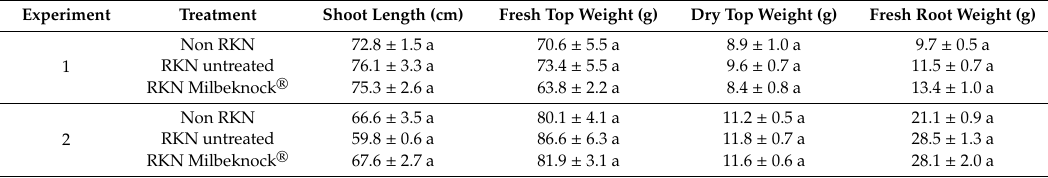
Table 2. E ff ects of Milbeknock ® on growth parameters of tomato ‘Roma’ infected by Meloidogyne javanica in pot experiments 47 days after transplanting tomato.